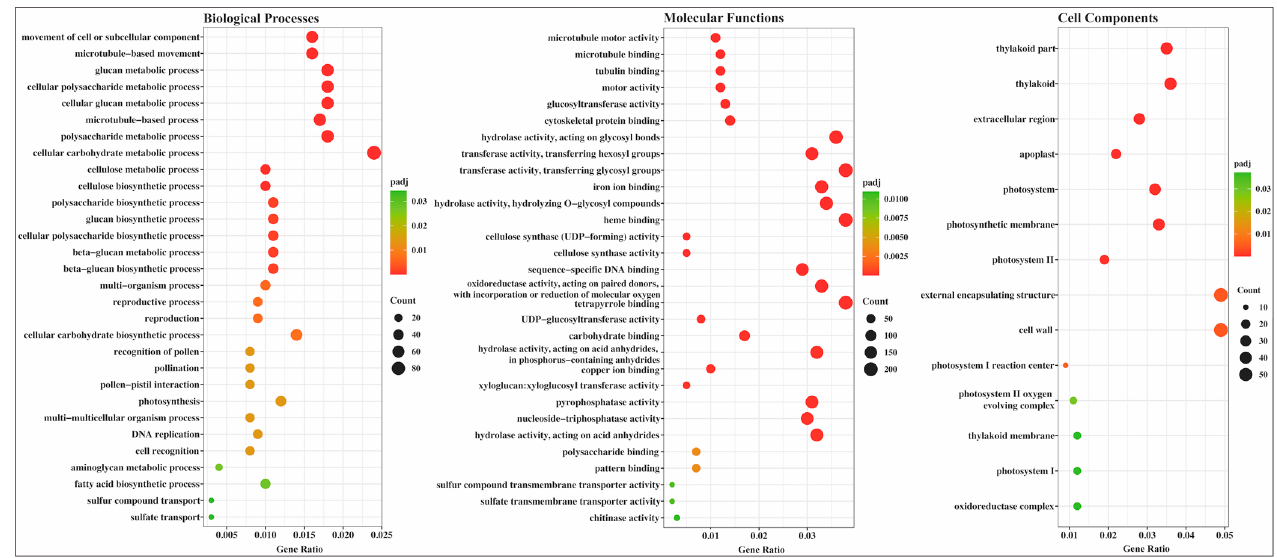
Figure 5. Gene ontology (GO) enrichment for differentially expressed genes in G. anomalum under drought stress. The closer to red, the more the differential genes contained under each function are represented by the size of the dots. Only top 30 significantly enriched GO terms of each category are displayed in the DEGs.